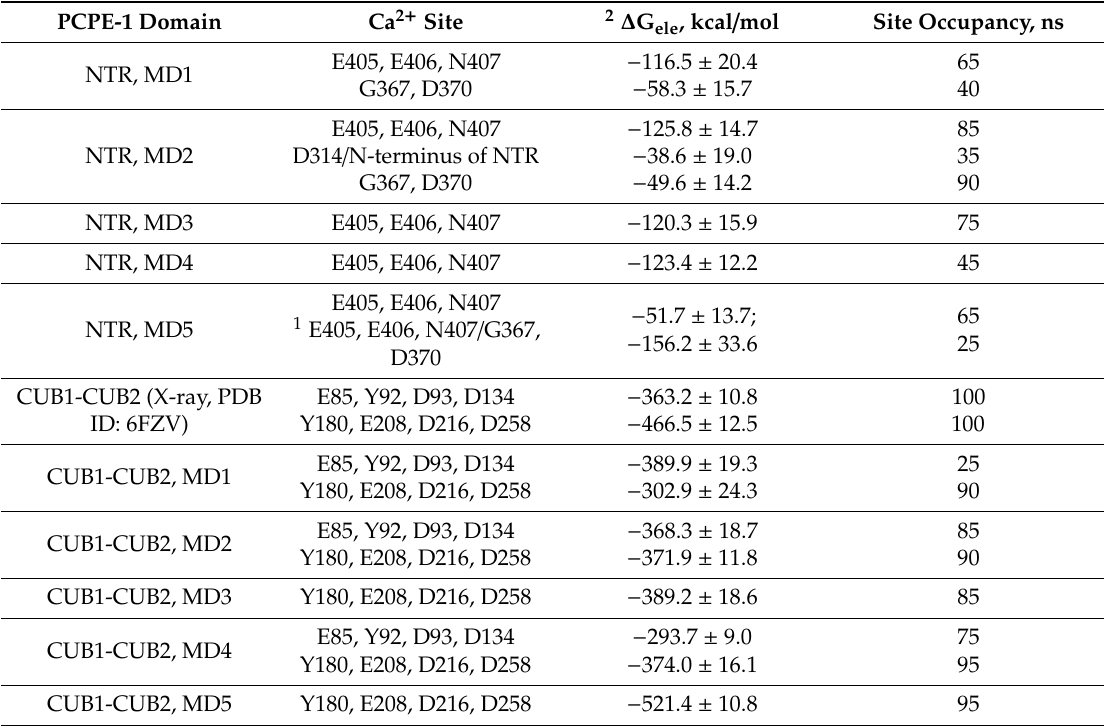
Table 8. MM-GBSA free energy calculations (per Ca 2 + ion) for the predicted Ca 2 + binding sites